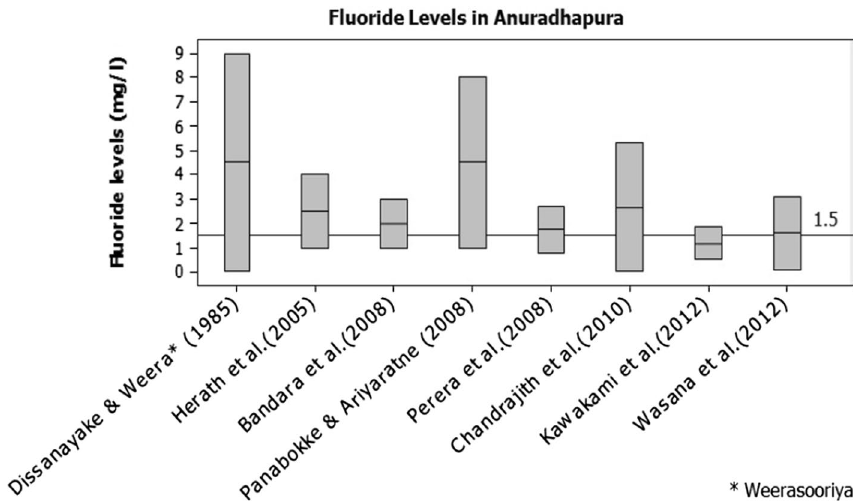
Fig. 1 Variation of fluoride concentration in Anuradhapura district according to research